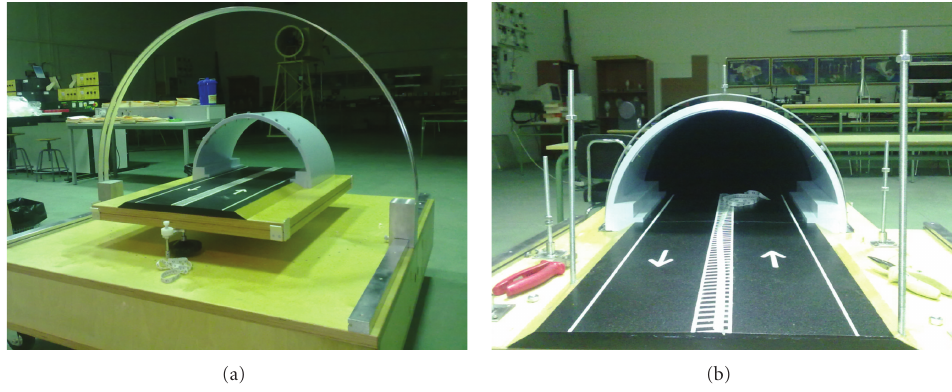
Figure 3: Mock-up of tunnel and the solar ecliptic plane.